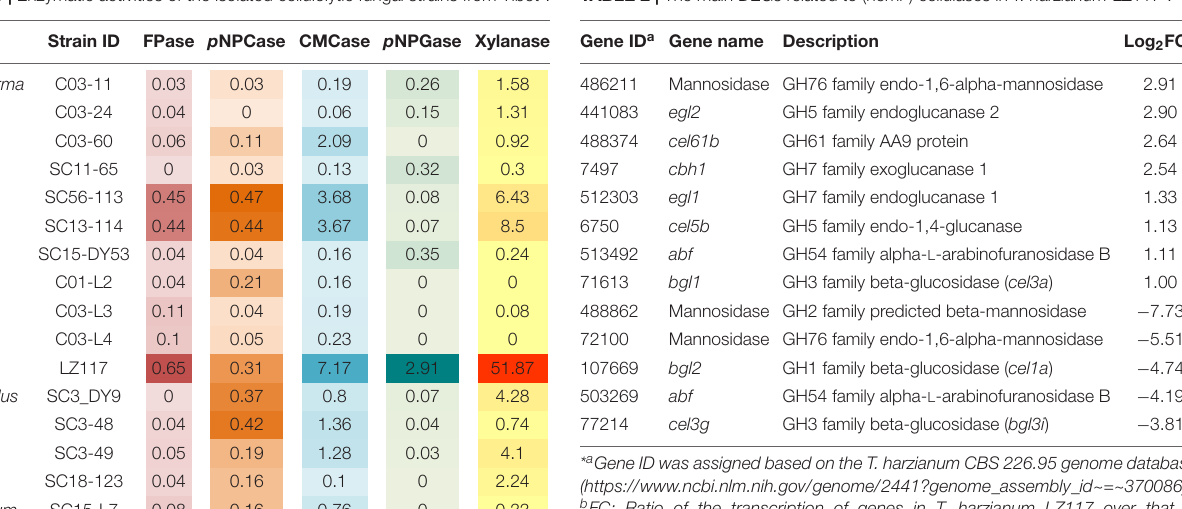
TABLE 2 | The main DEGs related to (hemi-) cellulases in T. harzianum